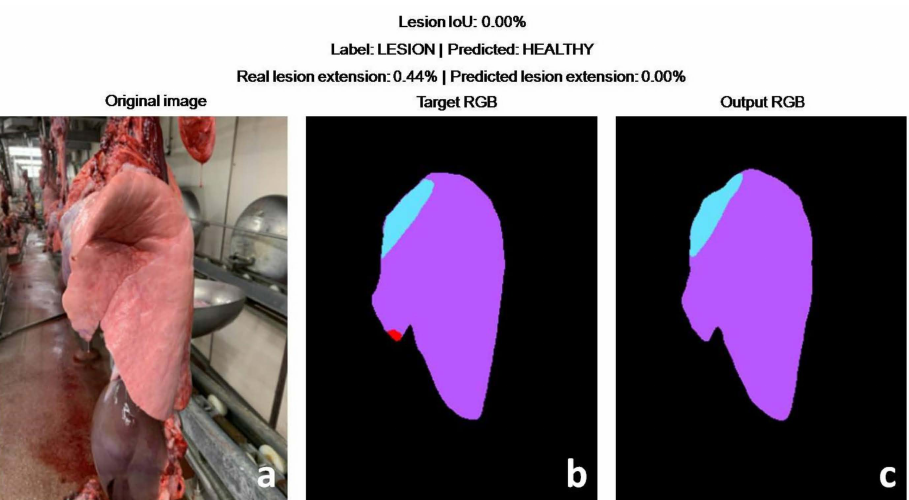
Figure 7. Test set. False negative prediction provided using the DL-based method. Pictures ( a , b ) represent the original picture and the annotation of the veterinarian, respectively. In detail, the veterinarian-annotated lung (purple), lobe (blue) and lesion (red). As shown in picture (( c ); DLBM prediction), the DLBM overlooked the very small lesion on the tip of the middle